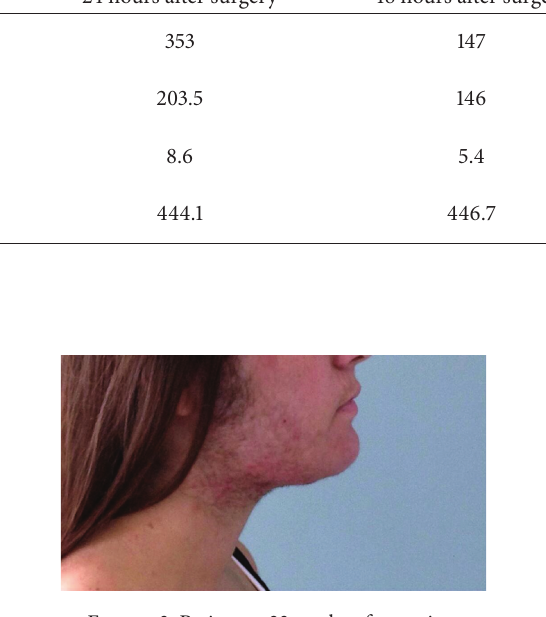
Figure 3: Patient at 23 weeks of